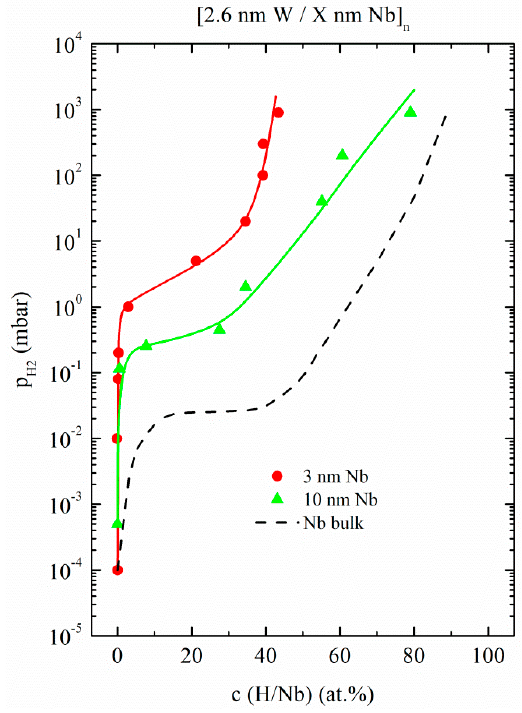
Figure 10. Hydrogen solubility curves of epitaxial [2.6 nm W/ d Nb ] n multilayers and Nb bulk material as indicated.